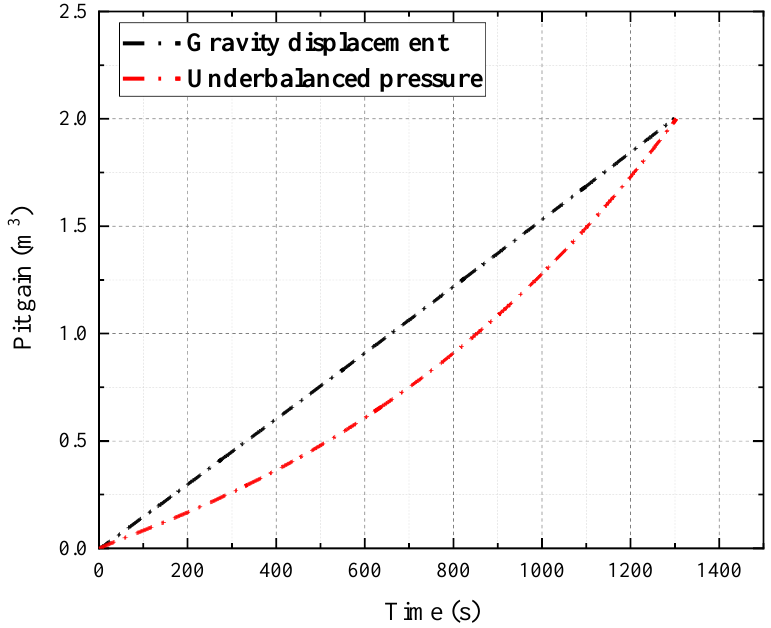
Figure 6. Comparison of the variation of the pit gain for well M.